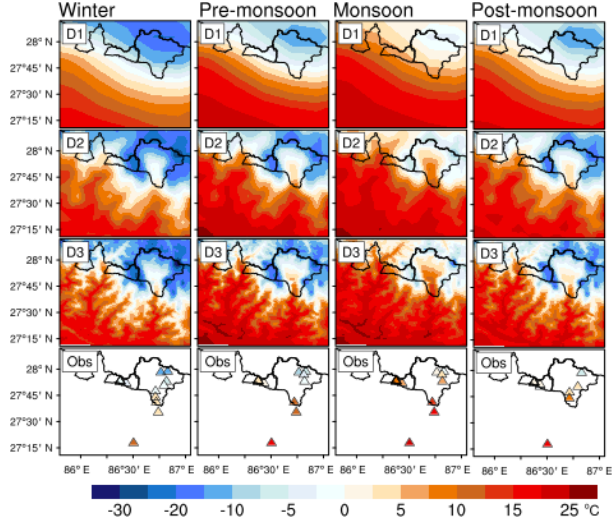
Figure 12. Spatial distribution of temperature ( ◦ C) for four seasons at three WRF resolutions and observations.